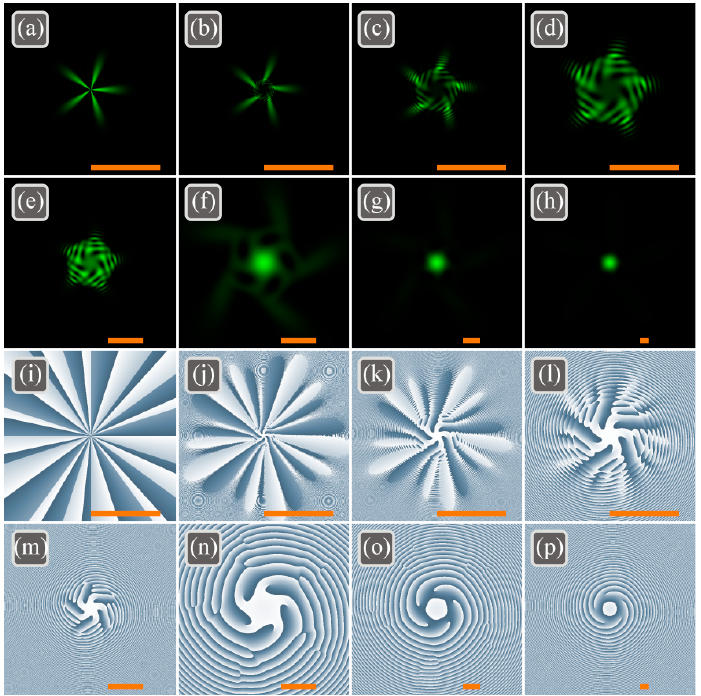
Figure 2. The intensity ( a – h ) and the phase ( i – p ) distributions of the light field (1) with n = 3, k = 0, m = 5, a = 1, w 0 = 500 μ m in the planes z = 0 ( a , i ), z = z 0 /200 ( b , j ), z = z 0 /50 ( c , k ), z = z 0 /20 ( d , l ), z = z 0 /10 ( e , m ), z = z 0 /2 ( f , n ), z = z 0 ( g , o ), z = 2 z 0 ( h , p ). The scale mark in each figure corresponds to 1 mm.